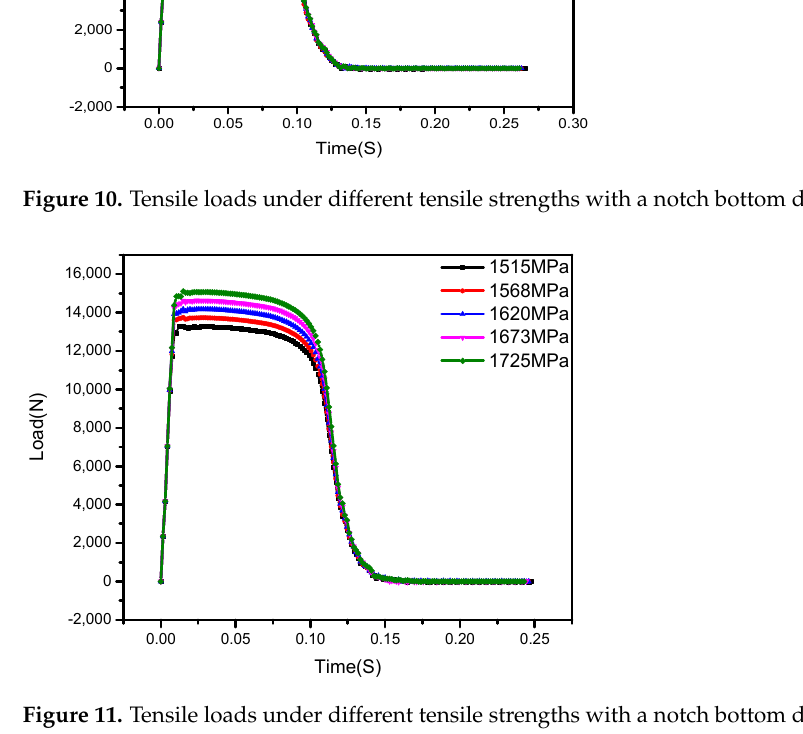
Figure 11. Tensile loads under different tensile strengths with a notch bottom diameter of 2.8 mm.